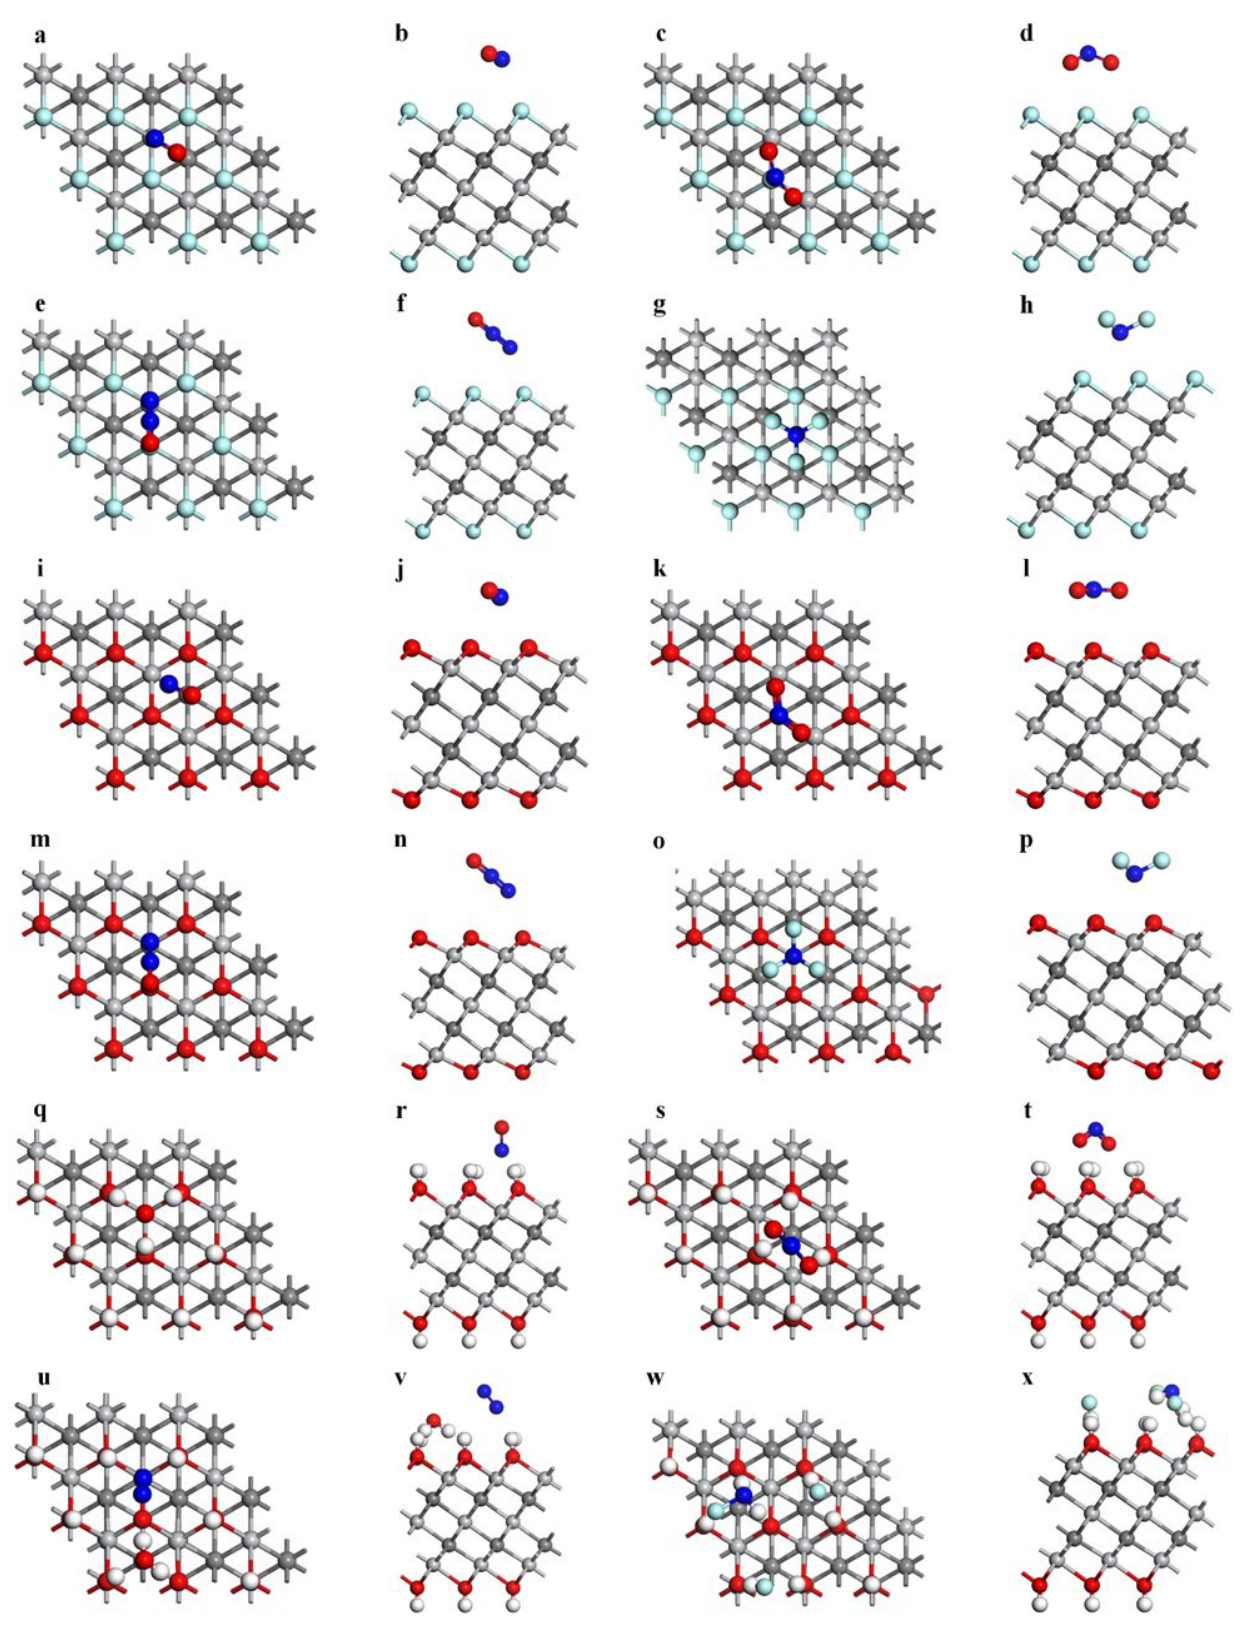
Figure 1. The most stable adsorption structures of NO, NO 2 , N 2 O, and NF 3 on ( a – h ) Ti 3 C 2 F 2 , ( i – p ) Ti 3 C 2 O 2 , and ( q – x ) Ti 3 C 2 (OH) 2. (Light gray–Ti, dark grey–C, cyan–F, red–O, blue–N, white–H).